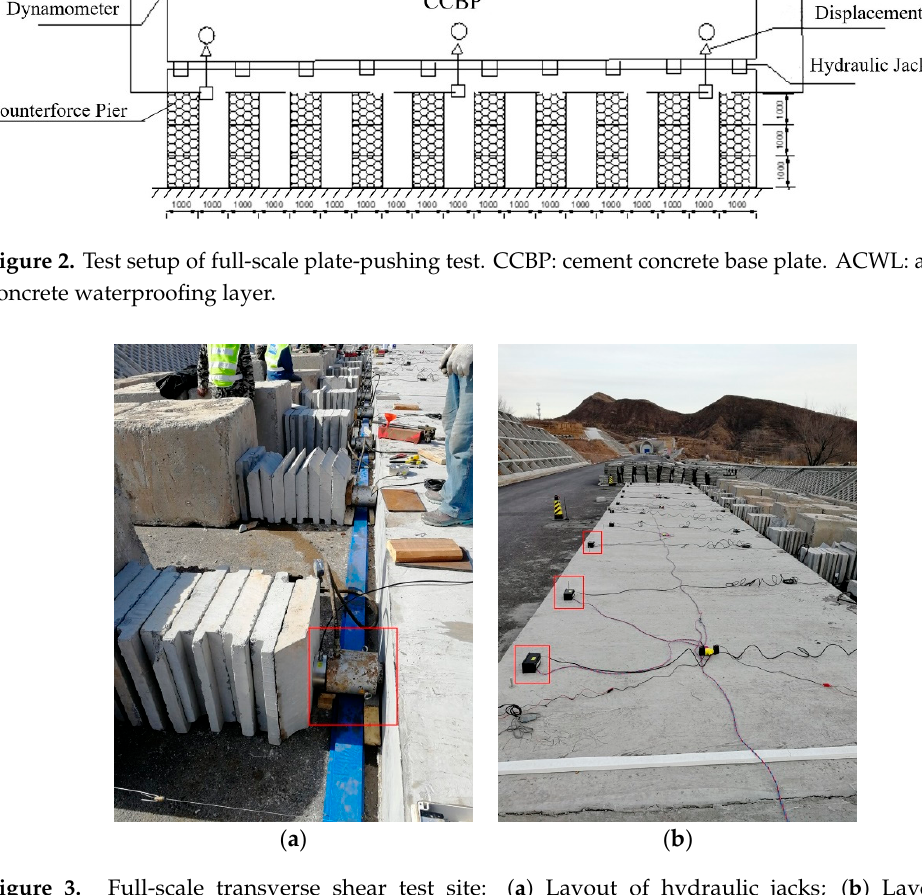
Figure 3. Full-scale transverse shear test site: ( a ) Layout of hydraulic jacks; ( b ) Layout of displacement